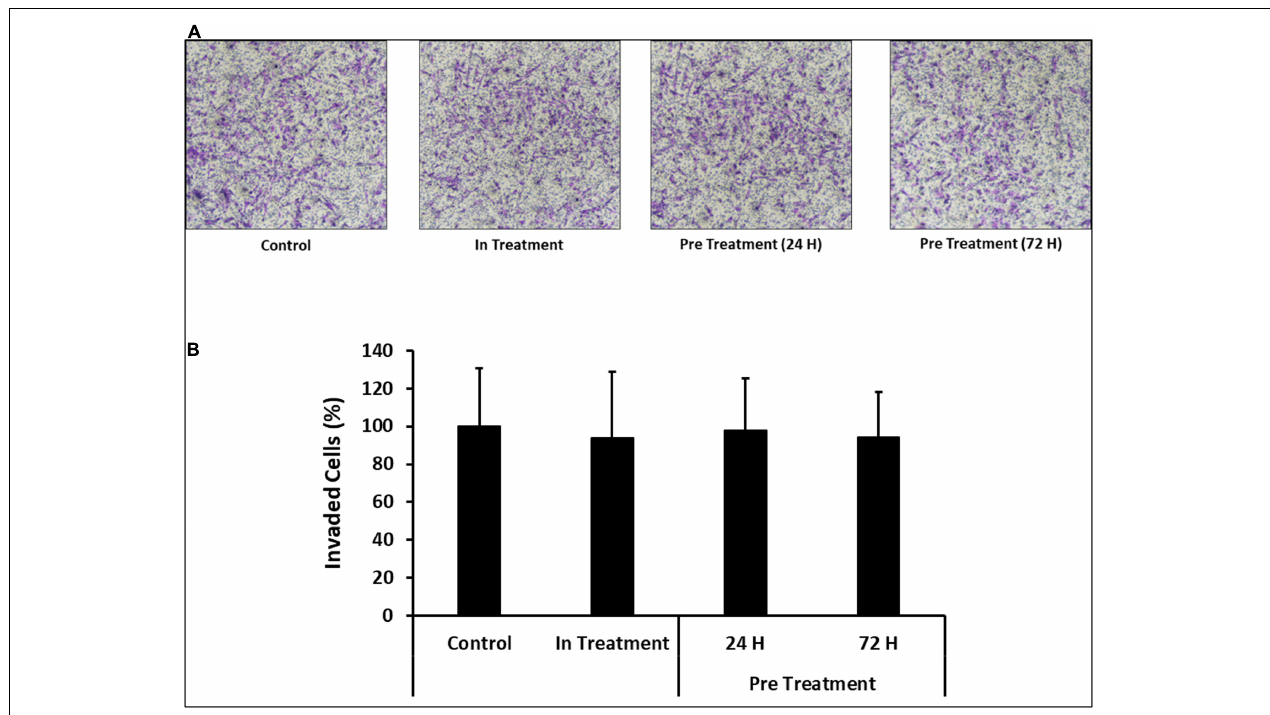
FIGURE 6 | Comparison of functional outcome of CV-MSCs before and after CM-MDA231 preconditioning. Invasion of CV-MSCs before and after preconditioning, was examined by adding the cells to a transwell insert with a pore size of 8 µ M, and covered with a layer of matrigel, as described in materials and methods section. After 24 h of culture, no significant change was observed in the invasion of cells preconditioned for 24 and 72 h as compared to in-treatment conditions and untreated control experiment groups. (A) Shows the photomicrograph of the migrated cells under various treatment conditions. Five different fields were counted and the percentage of total migrated cells are plotted in a bar graph (B) . Each experiment was performed three times and repeated with the cells isolated from five different placentae. Bars represent standard